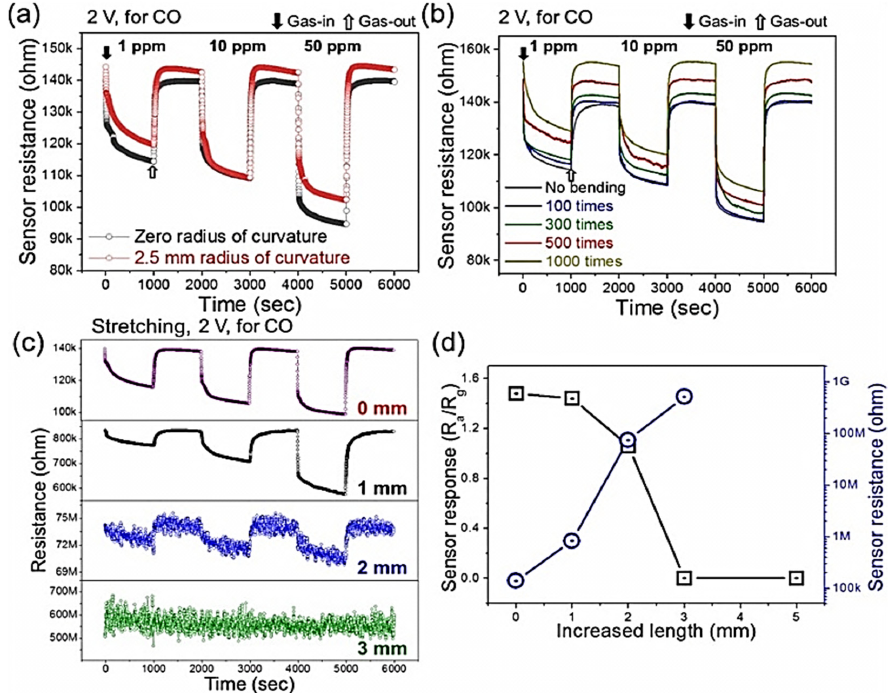
Figure 30. Curves showing resistance as a function of time for the sensor based on Au-functionalized WS 2 for response toward 50 ppm CO at 2 V without bending and with bending at the radii of cur- vature of ( a ) 2.5 mm and ( b ) 4 mm for several bending cycles. ( c ) Resistance curves of the sensor with Au-functionalized WS 2 nanoflakes stretched for different lengths. ( d ) Response and resistance of Au-WS 2 gas sensor (irradiated for 15 s) with increased length (toward 50 ppm CO gas at 2 V). All the gas-sensing tests were performed at room temperature (25 °C). Reproduced from [107] with the permission of Elsevier.